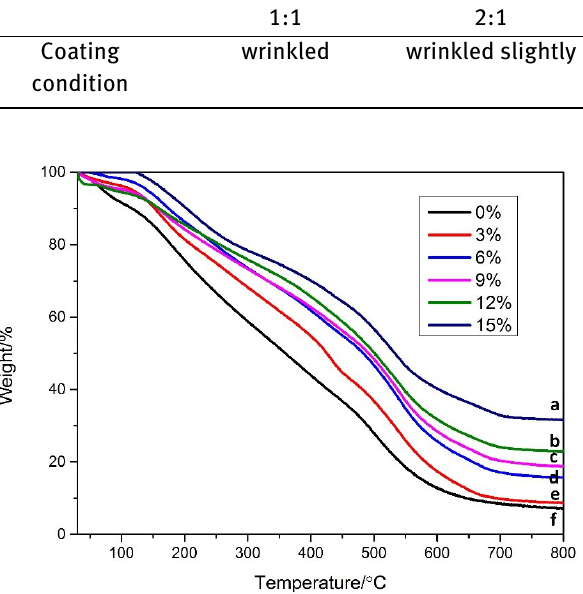
Figure 12: The thermogravimetric curve of VTMS/BA-m- compos- ite particle hybrid coating containing different mass fraction of composite particles. (a) 15%; (b) 12%; (c) 9%; (d) 6%; (e) 3%; (f) 0%